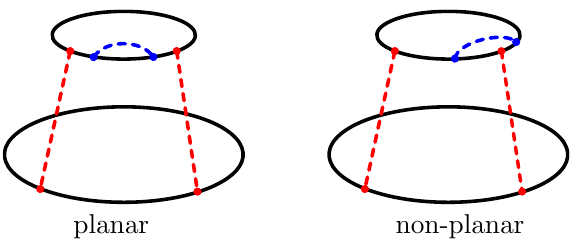
Figure 3 . Red and blue lines represent ladder and rainbow propagators respectively. Rainbow propagators passing over the endpoints of another propagator, as in the picture on the right, render the diagram non-planar, which is suppressed in the large N